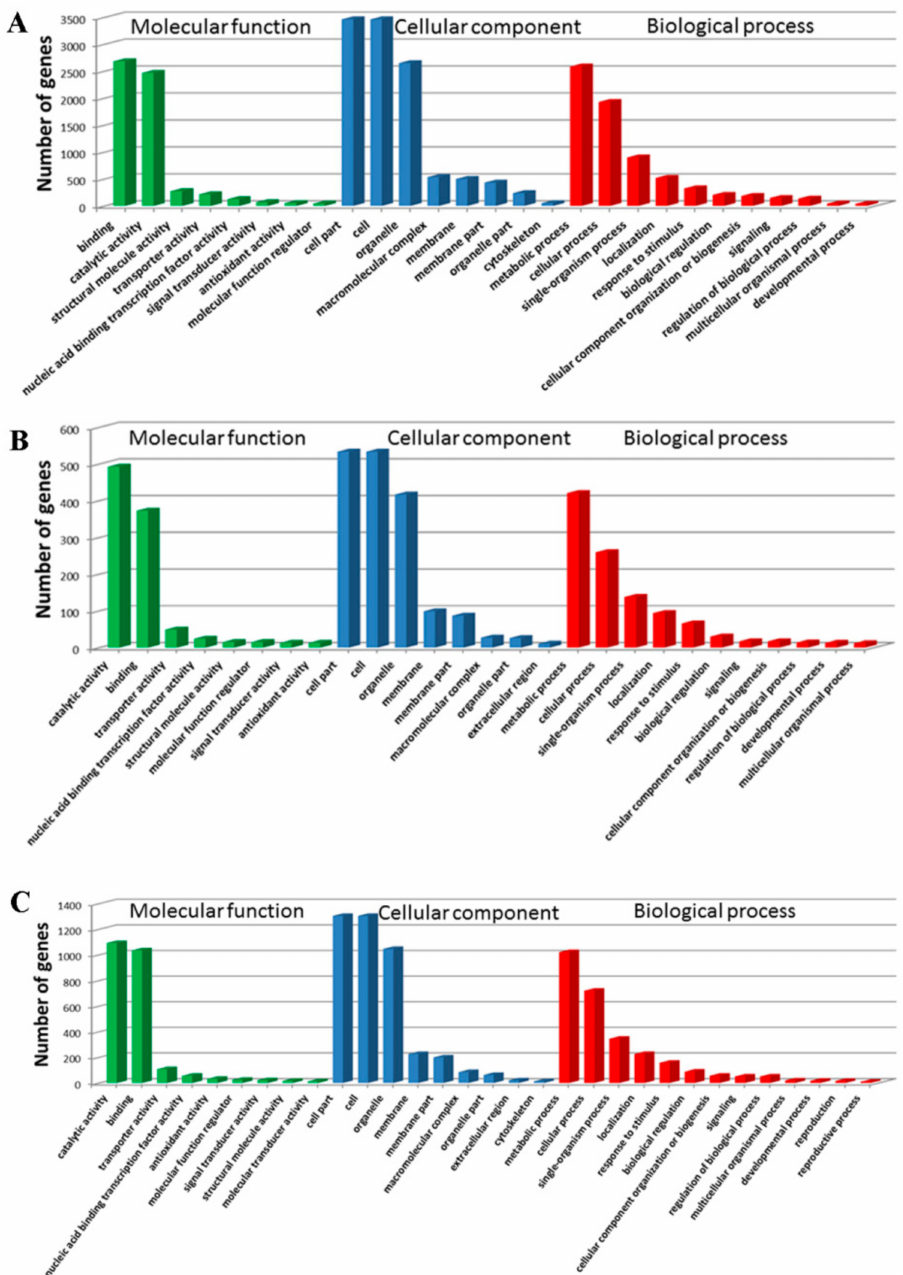
Figure 4. The GO analysis of DEGs in CML530 vs. QCL8011_2 at 18 DAP ( A ), 28 DAP ( B ), and 38 DAP ( C ). X axis represents GO terms. Y axis means number of DEGs. All GO terms are grouped in to three ontologies—brown is for molecular function, blue is for cellular component, and orange is for biological